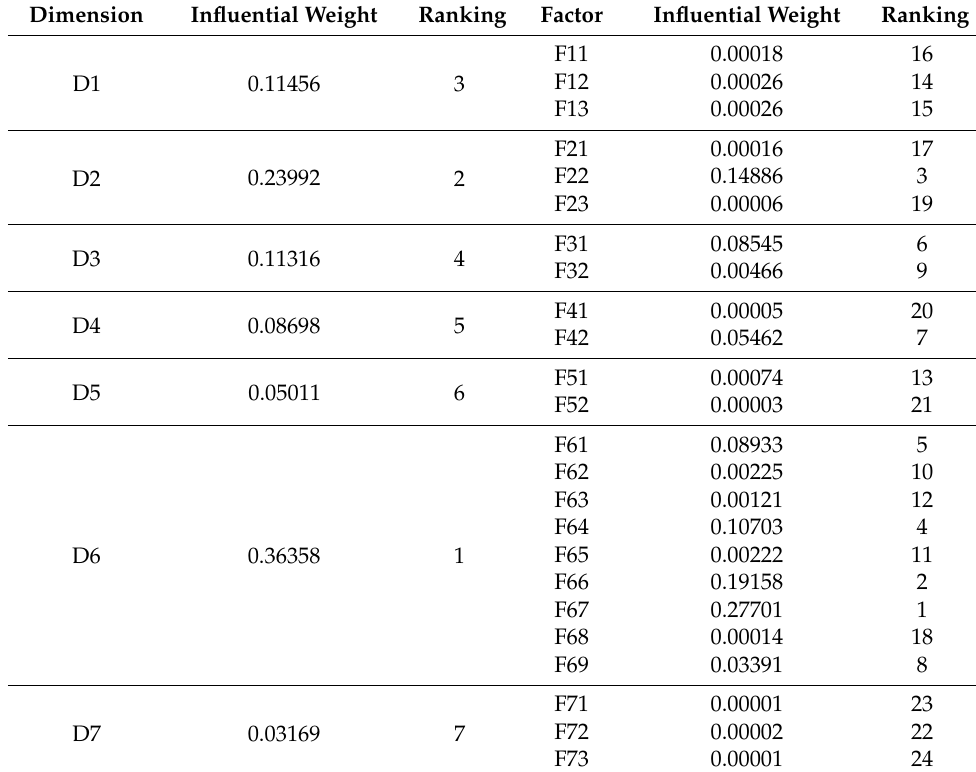
Table 6. Influential weights of dimensions and delay factors in prefabricated